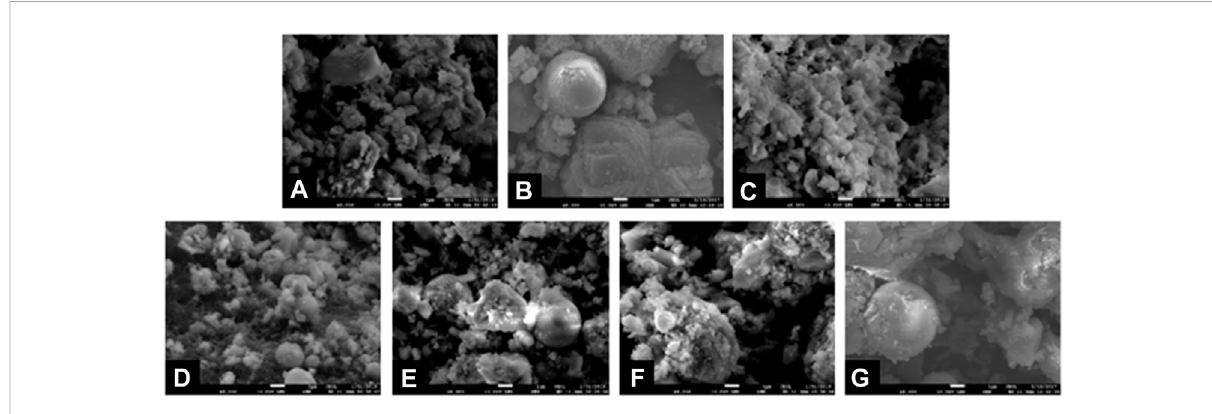
FIGURE 13 MicrostructuresofMSWIproducts solidi fi edbydifferentmicrobecementcontents: (A) 0%; (B) 10%; (C) 20%; (D) 30%; (E) 40%; (F) 50%; (G)